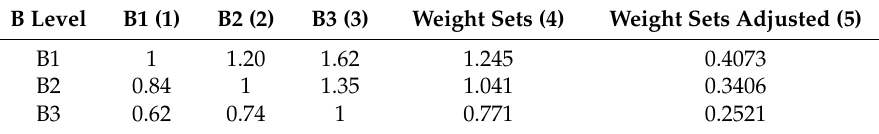
Table 6. The illustration of the weight set calculation for the B